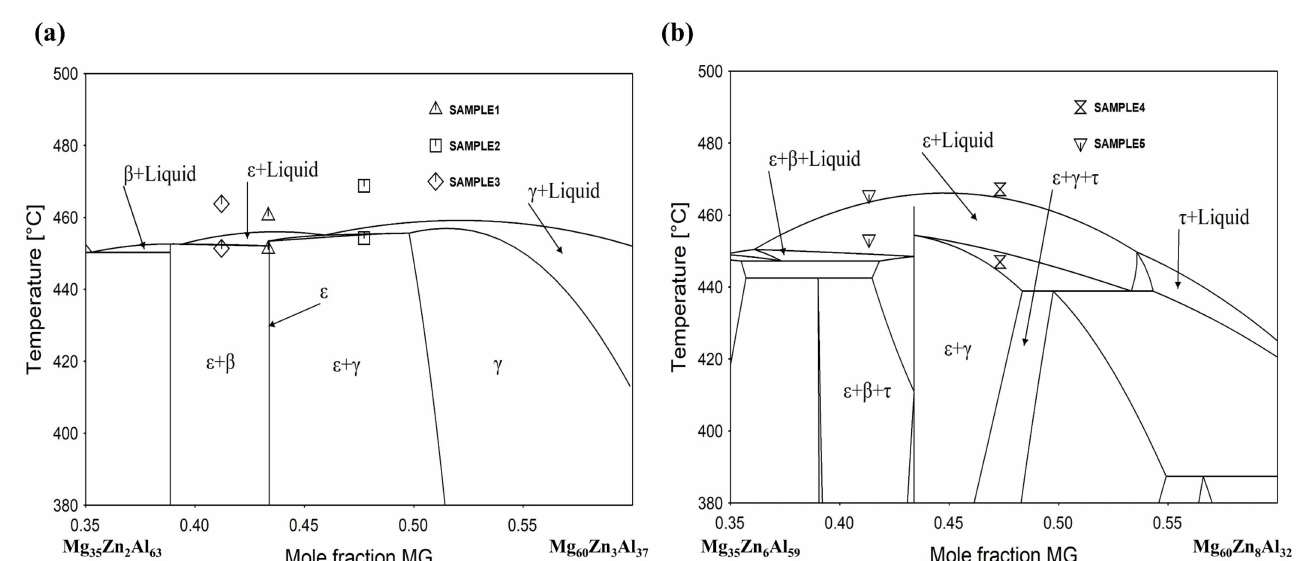
Figure 5. Calculated vertical section of the Mg-Zn-Al system ( a ) along with the DSC data of samples 1–3 and ( b ) along with the DSC data of samples 4 and